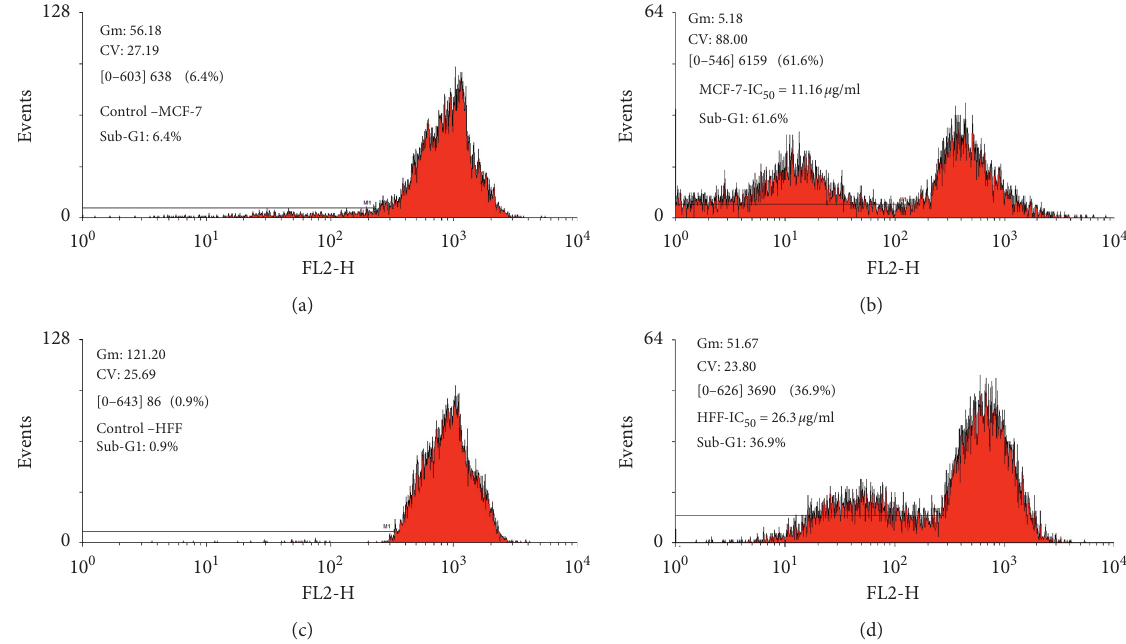
Figure 6: The effect of S. officinalis -mediated ZnO-NPs on the cell cycle progression in MCF7 and HFF cell lines. The cell cycle analysis of MCF7 and HFF cells after 24h of treatment with 11.16 μ g/mL and 26.3 μ g/mL of ZnO-NPs, respectively, revealing that the population of cells in the sub-G1 phase increased with increasing ZnO-NPs in IC 50 compared with untreated